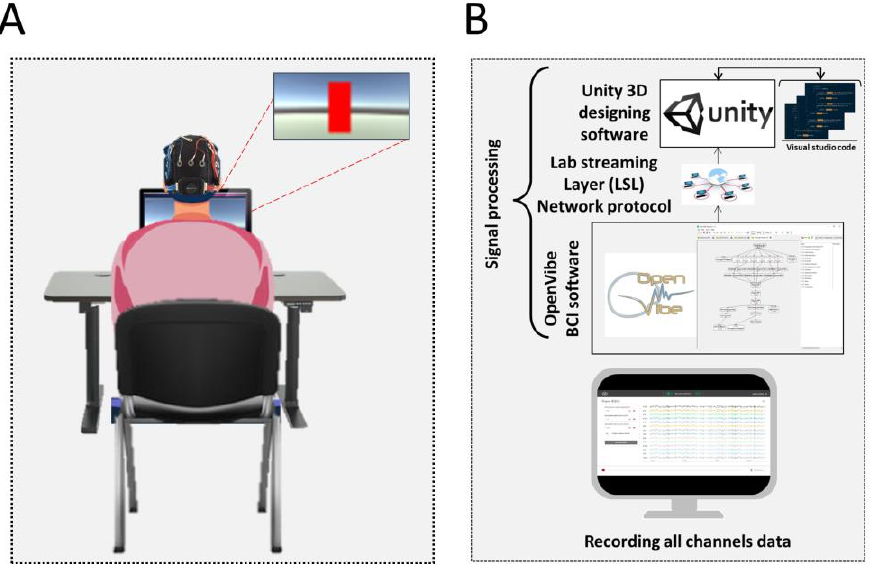
Figure 1. Representation of the NFT training system. ( A ) A participant is sitting in front of the feedback screen, and the visual feedback is shown as a red vertical bar on the screen. ( B ) The EEG data are recorded for the offline analysis, and the signal processing module in OpenVibe is connected with the Unity3D via LSL protocol.